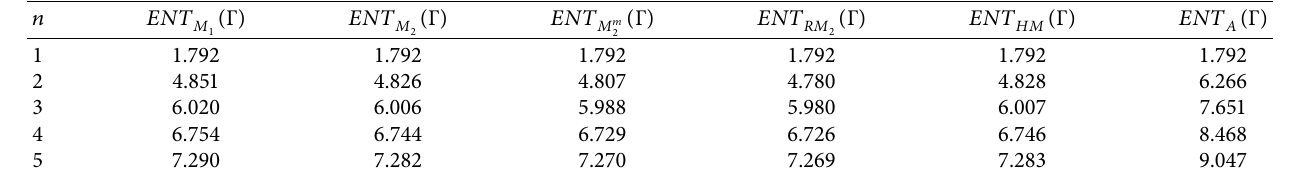
Table 4: Numerical comparison for Theorem 4.